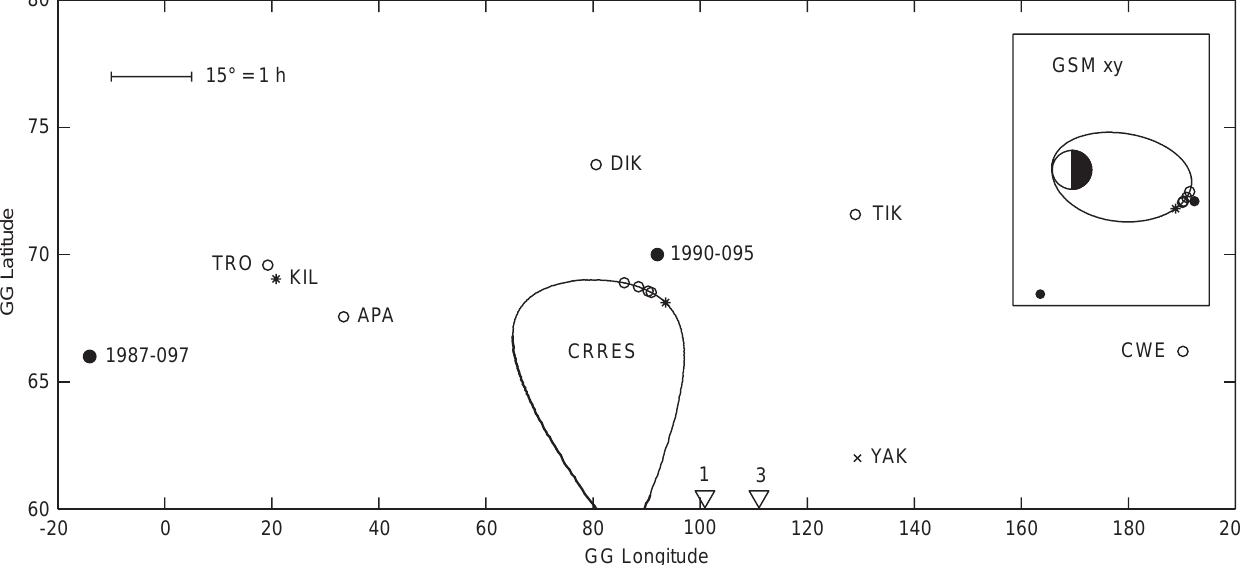
for more details). The locations of the geosynchronous satellites (cid:133)(cid:15)(cid:134) are shown for 1700 UT. Equatorial projection in GSM coordinates can be seen in the inset